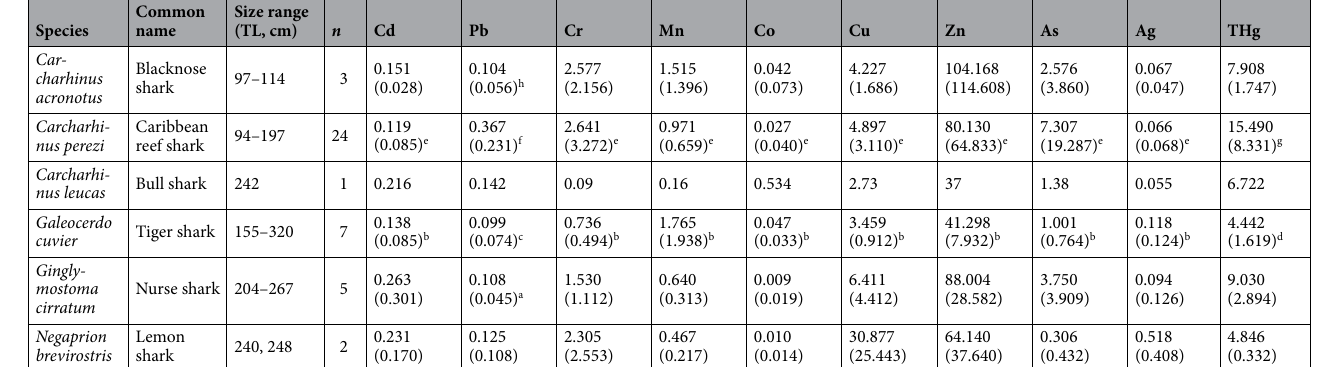
Table 1. Mean heavy metal concentrations (± SD, mg kg −1 , dw) measured in white muscle tissue of sharks captured from coastal waters of Great Exuma and Nassau New Providence Island, The Bahamas. Sample sizes ( n ) represent the total number of individuals sampled from which metal data were generated, the sample sizes of individual metals may differ based on the removal of data due to potential contamination. a n = 4. b n = 4. c n = 3. d n = 6. e n = 21. f n = 19. g n = 23. h n = 2.